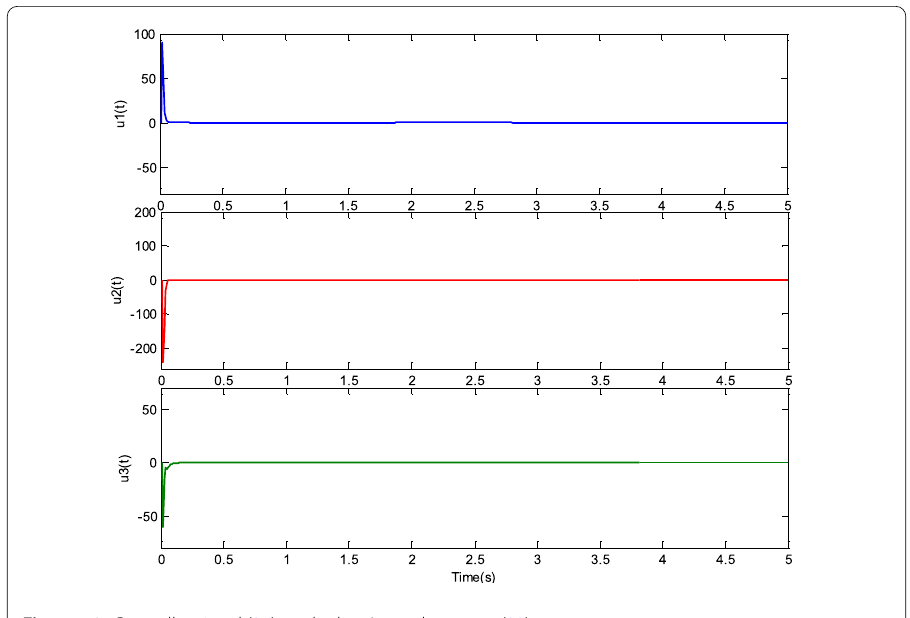
Figure 12 Controller signal (25) applied to Arneodo system